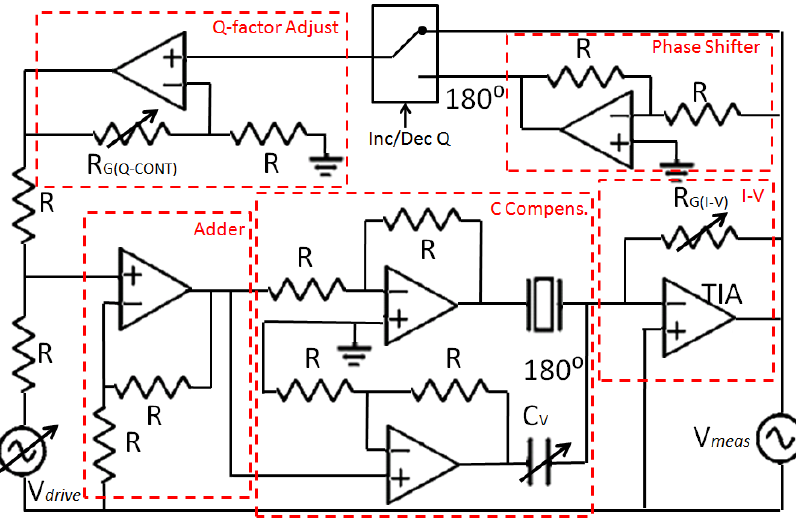
Figure 6. Scheme of the electronic driver. Feedback is made in the current through the fork (in-phase to increase Q and counter-phase to lower Q